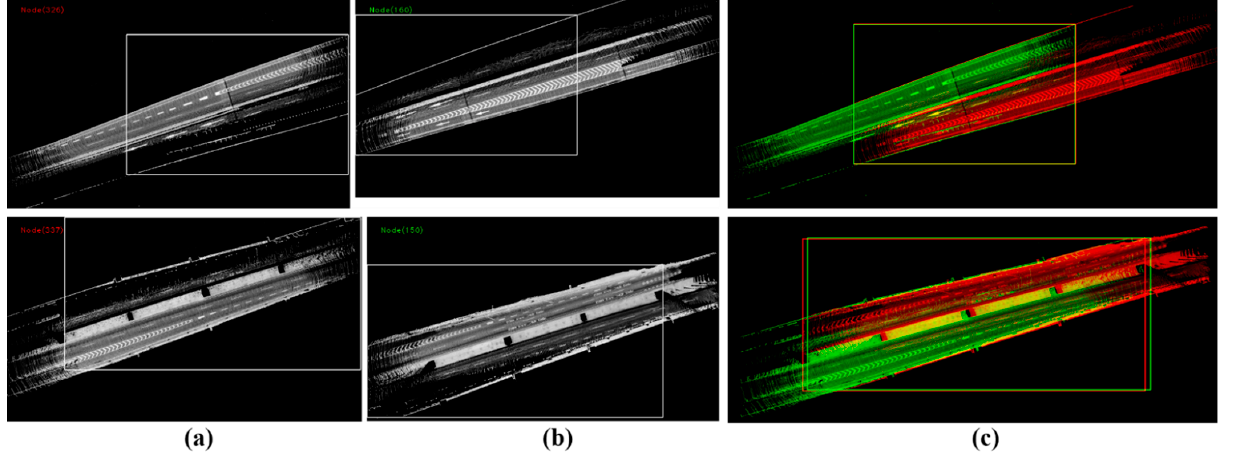
Figure 14. GIR map accuracy in the same global area in XY plane in the two layers of the bridge (1st row) and underpass (2nd row). ( a ) Node of the direct lane. ( b ) Node of the opposite lane. ( c ) Merging two nodes using the GIR system. The underpass layer shows a massive longitudinal deviation because of the obstruction of satellite signals by the bridge layer.